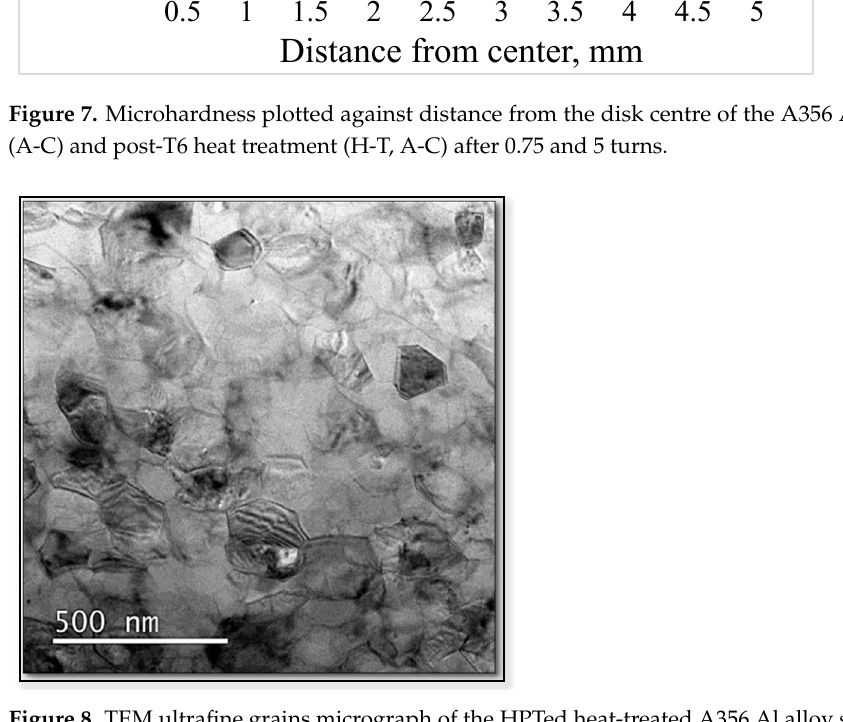
Figure 8. TEM ultrafine grains micrograph of the HPTed heat-treated A356 Al alloy sample.